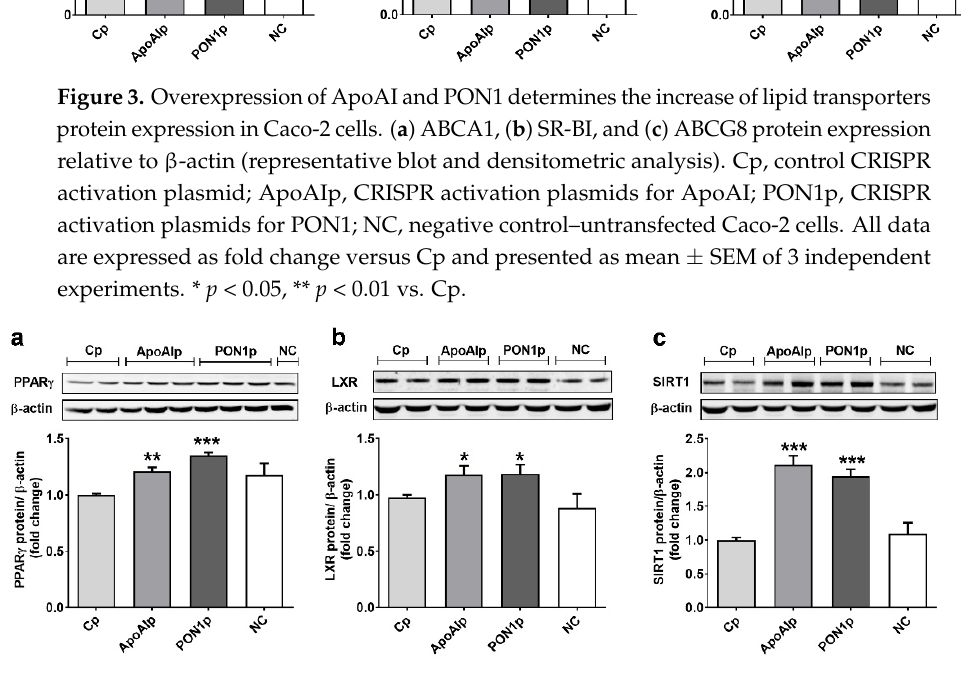
Figure 4. Overexpression of ApoAI and PON1 increases the protein expression of transcription factors involved in lipid transporters regulation in Caco-2 cells. ( a ) PPAR γ , ( b ) LXR, and ( c ) SIRT1 protein expression relative to β -actin (representative blot and densitometric analysis). Cp, control CRISPR activation plasmid; ApoAIp, CRISPR activation plasmids for ApoAI; PON1p, CRISPR activation plasmids for PON1; NC, negative control–untransfected Caco-2 cells. All data are expressed as fold change versus Cp and presented as mean ± SEM of 3 independent experiments. * p < 0.05, ** p < 0.01, *** p < 0.001 vs. Cp.